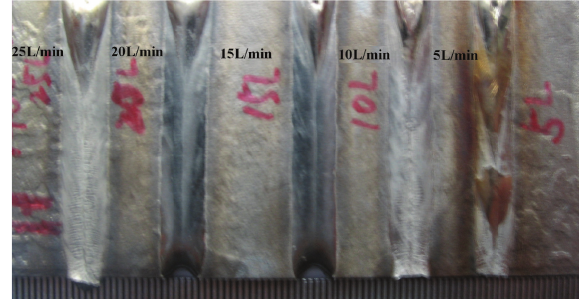
Figure 7: Influence of side-blow shielding gas flow rate on forma- tion of welded seam. ( 𝑃 = 1.5 kW; 𝑉 = 0.9 m/min; Δ𝑍 = 0 mm).